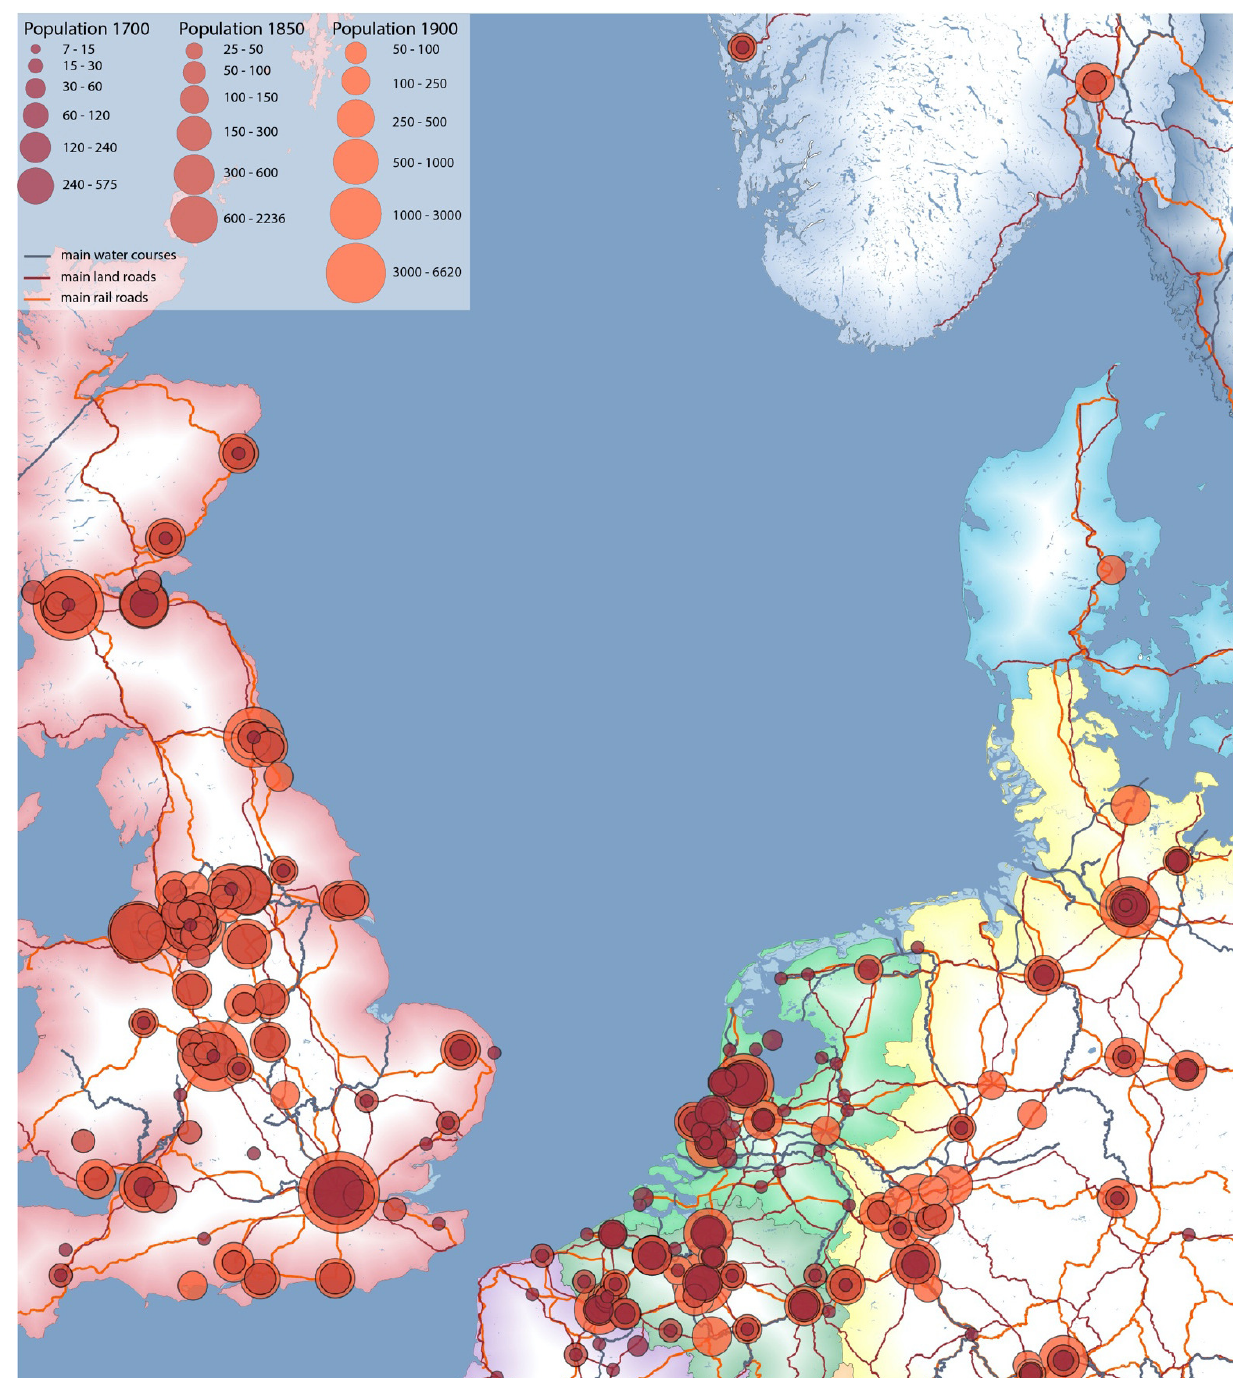
Figure 8. Cities around the North Sea area with the largest populations in 1700, 1850, and 1900, combined with political boundaries and infrastructure over land, rail, and water in 1900. Map by Yvonne van Mil. Source: van Mil and Rutte (2020a,